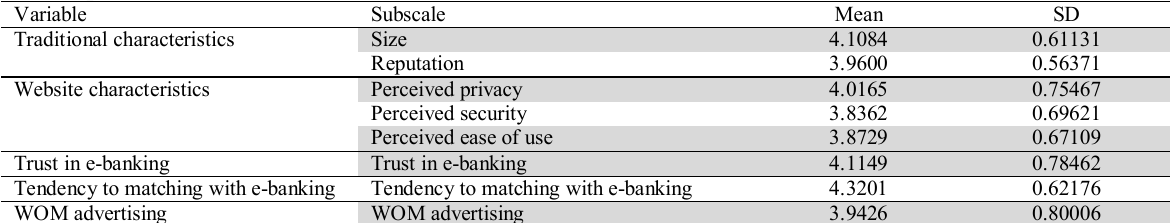
Descriptive statistics of research variables